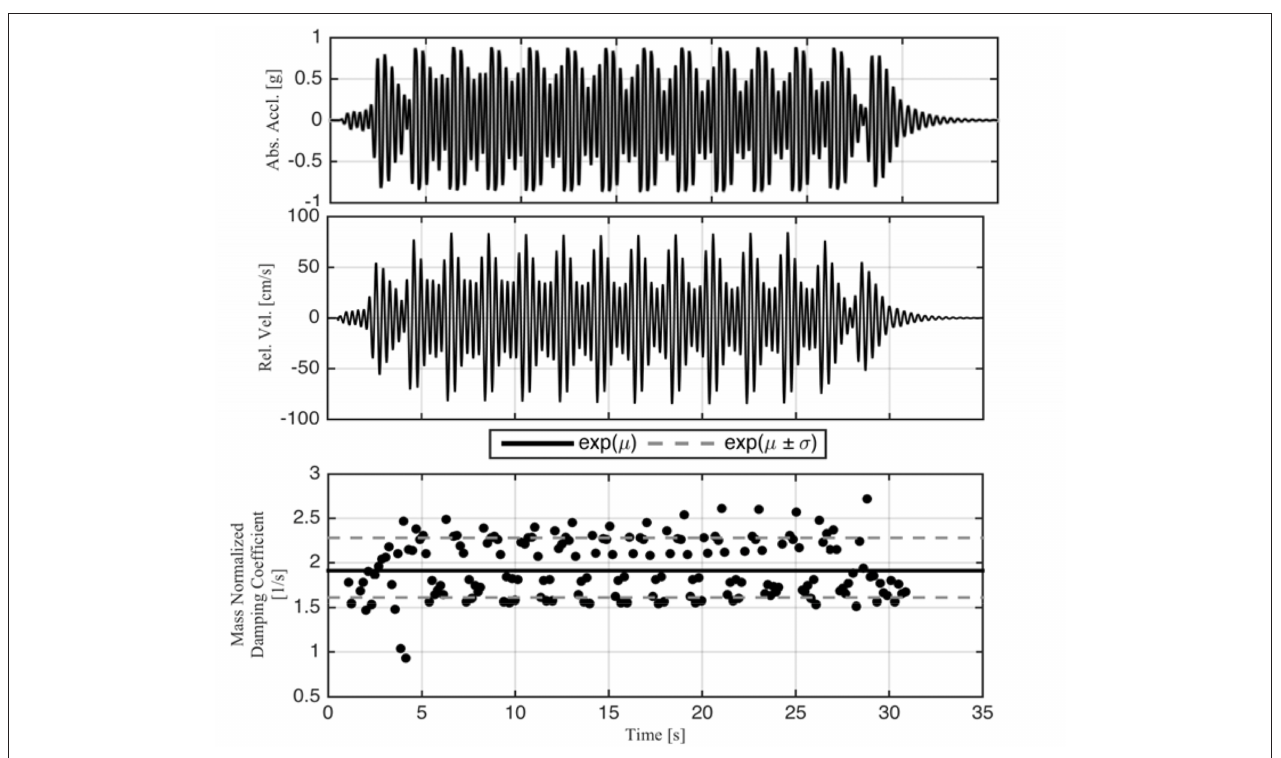
FIGURE 7 | Mass-normalized damping coefficient—Elastic.